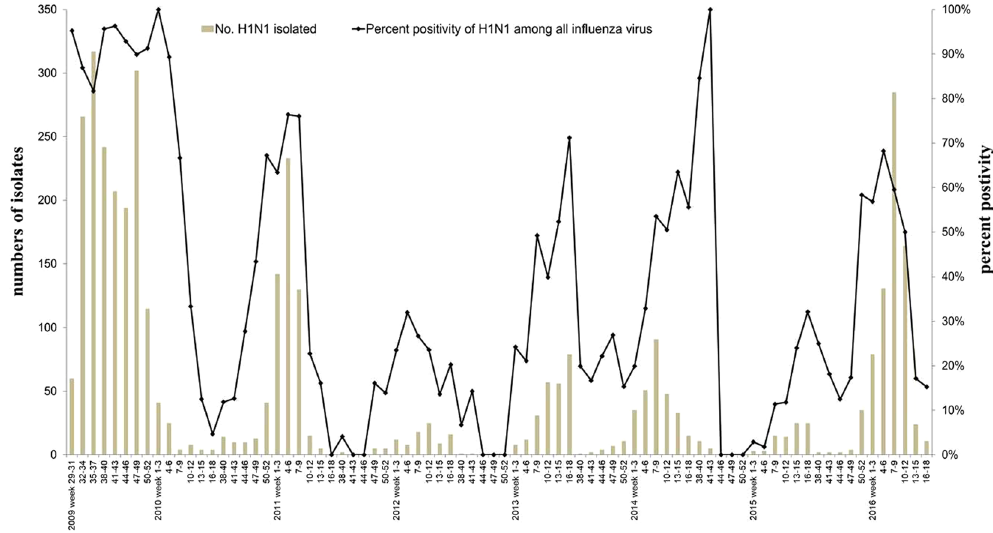
Figure 1. Isolate numbers of influenza A(H1N1)pdm09 virus and percentage of influenza A(H1N1)pdm09 virus among all influenza viruses during 2009/2010 to 2015/2016 seasons. Data for weeks 19–37 were not